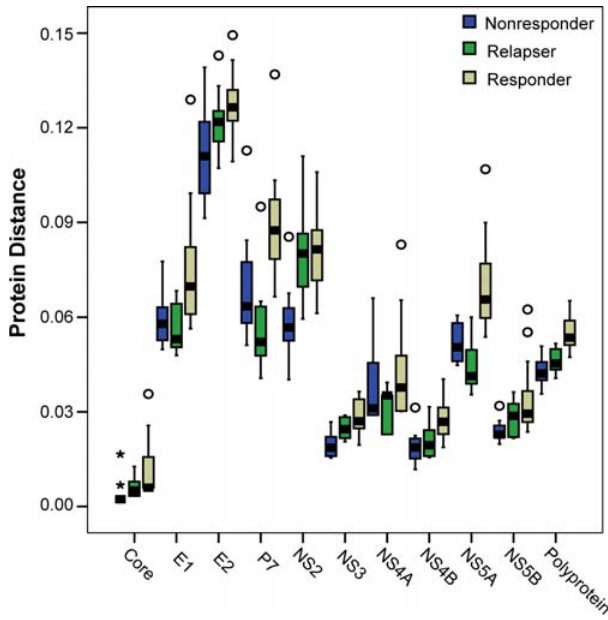
Figure 5. Protein distance in nonresponders, relapsers, and responder pre-therapy sequences. Comparison of the protein distances in three-phenotypes of patients.